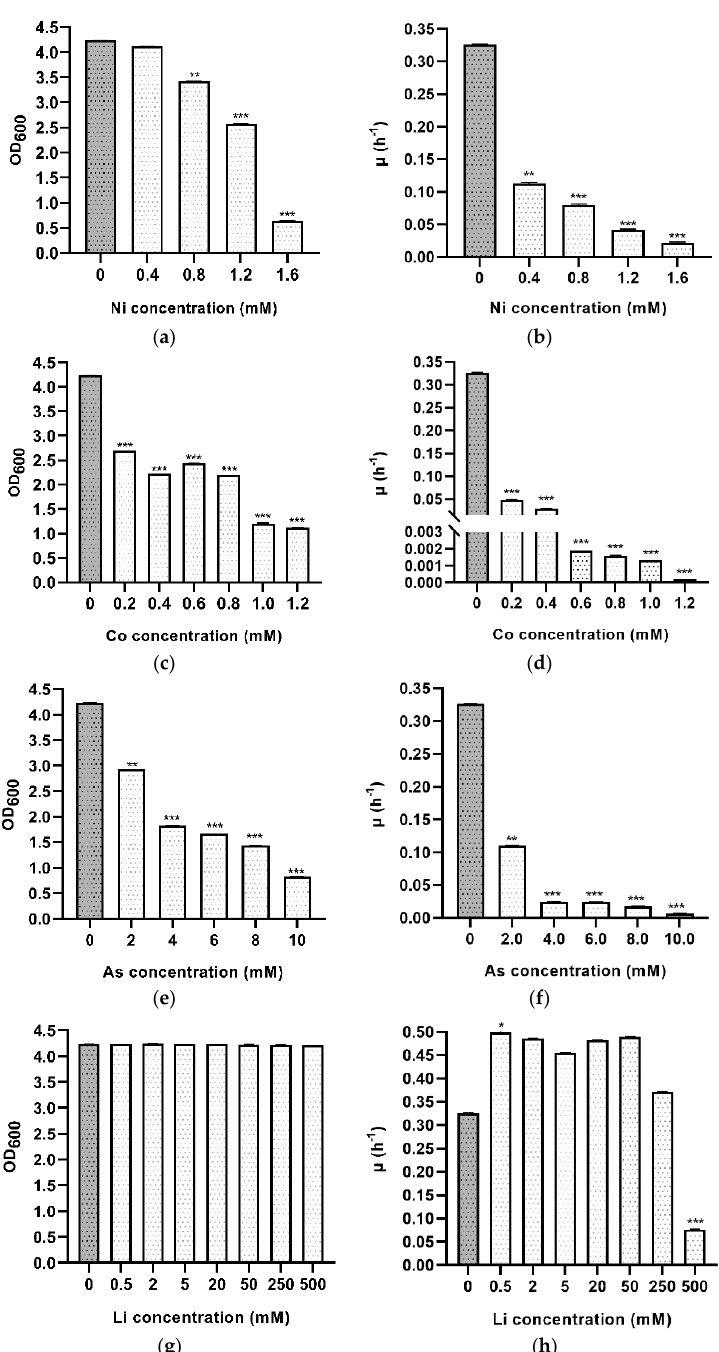
Figure 5. Effects of heavy metal stress on the growth profile of Hfx. mediterranei R4 grown in Hm-DM. Data are based on three independent cultures. ( a ) Maximum OD 600 in stationary phase adding Ni 2+ (reached at different times). ( b ) Average growth rate with Ni 2+ ( c ) Maximum OD 600 in the stationary phase adding Co 2+ (reached at different times). ( d ) Average growth rate with Co 2+ ( e ). Maximum OD 600 in stationary phase adding As 5+ (reached at different times). ( f ) Average growth rate with As 5+ . ( g ) Maximum OD 600 in the stationary phase adding Li + (reached at the same times). ( h ) Average growth rate with Li + . Plotted values are the mean of triplicate measurements, and error bars represent ± SD. * p ≤ 0.05; ** p ≤ 0.01; *** p ≤ 0.001. In grey, control without toxic metals; in white, with toxic metals.